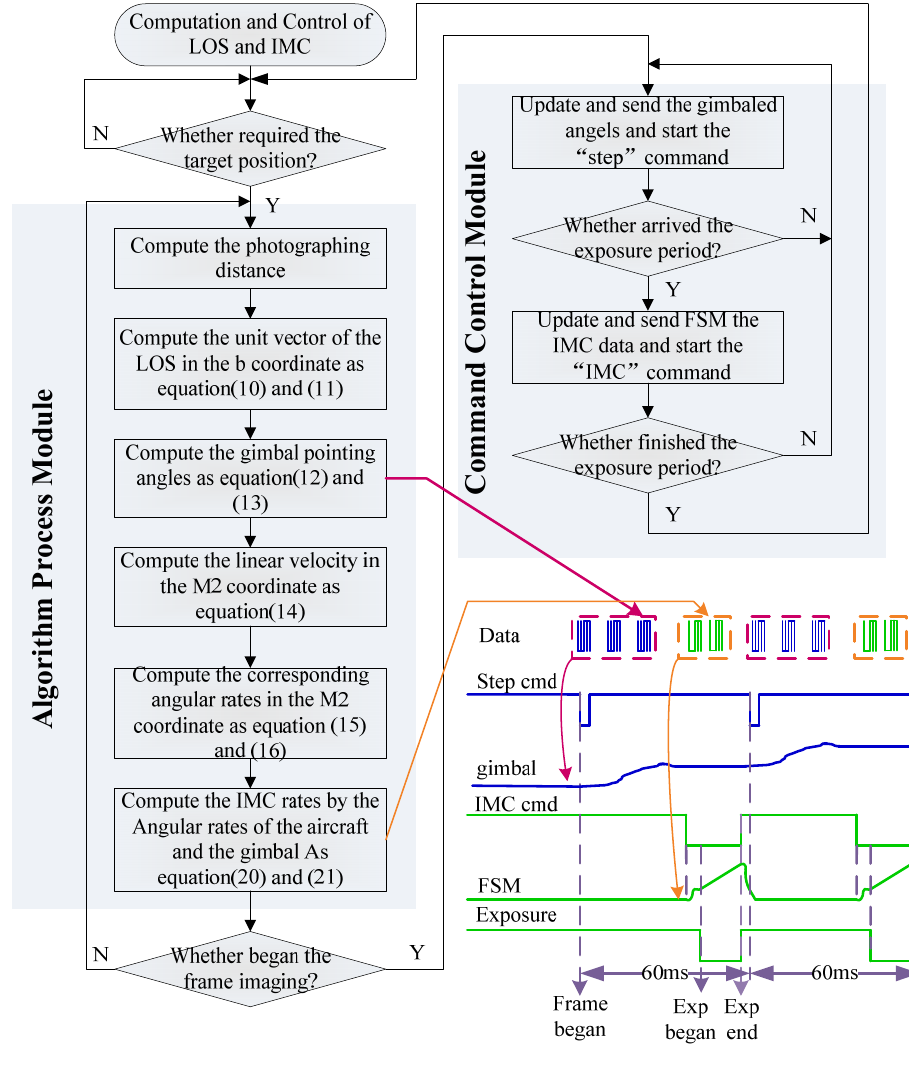
Figure 7. Control flow chart of the system.